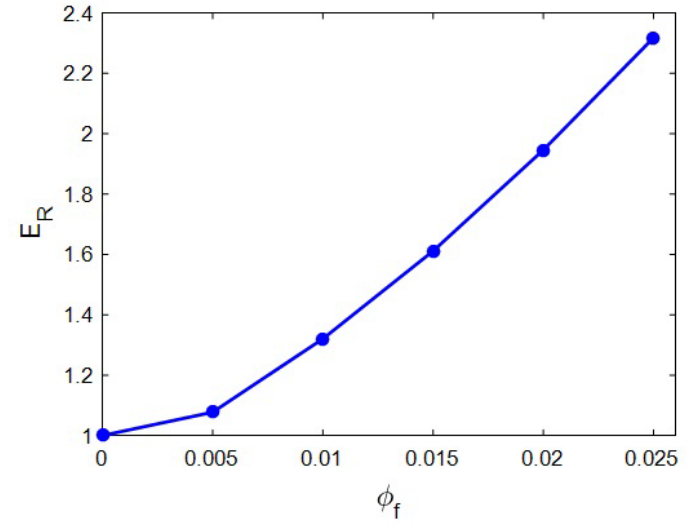
Figure 2. Predictions of “ E R ” at various HNT volume portions.